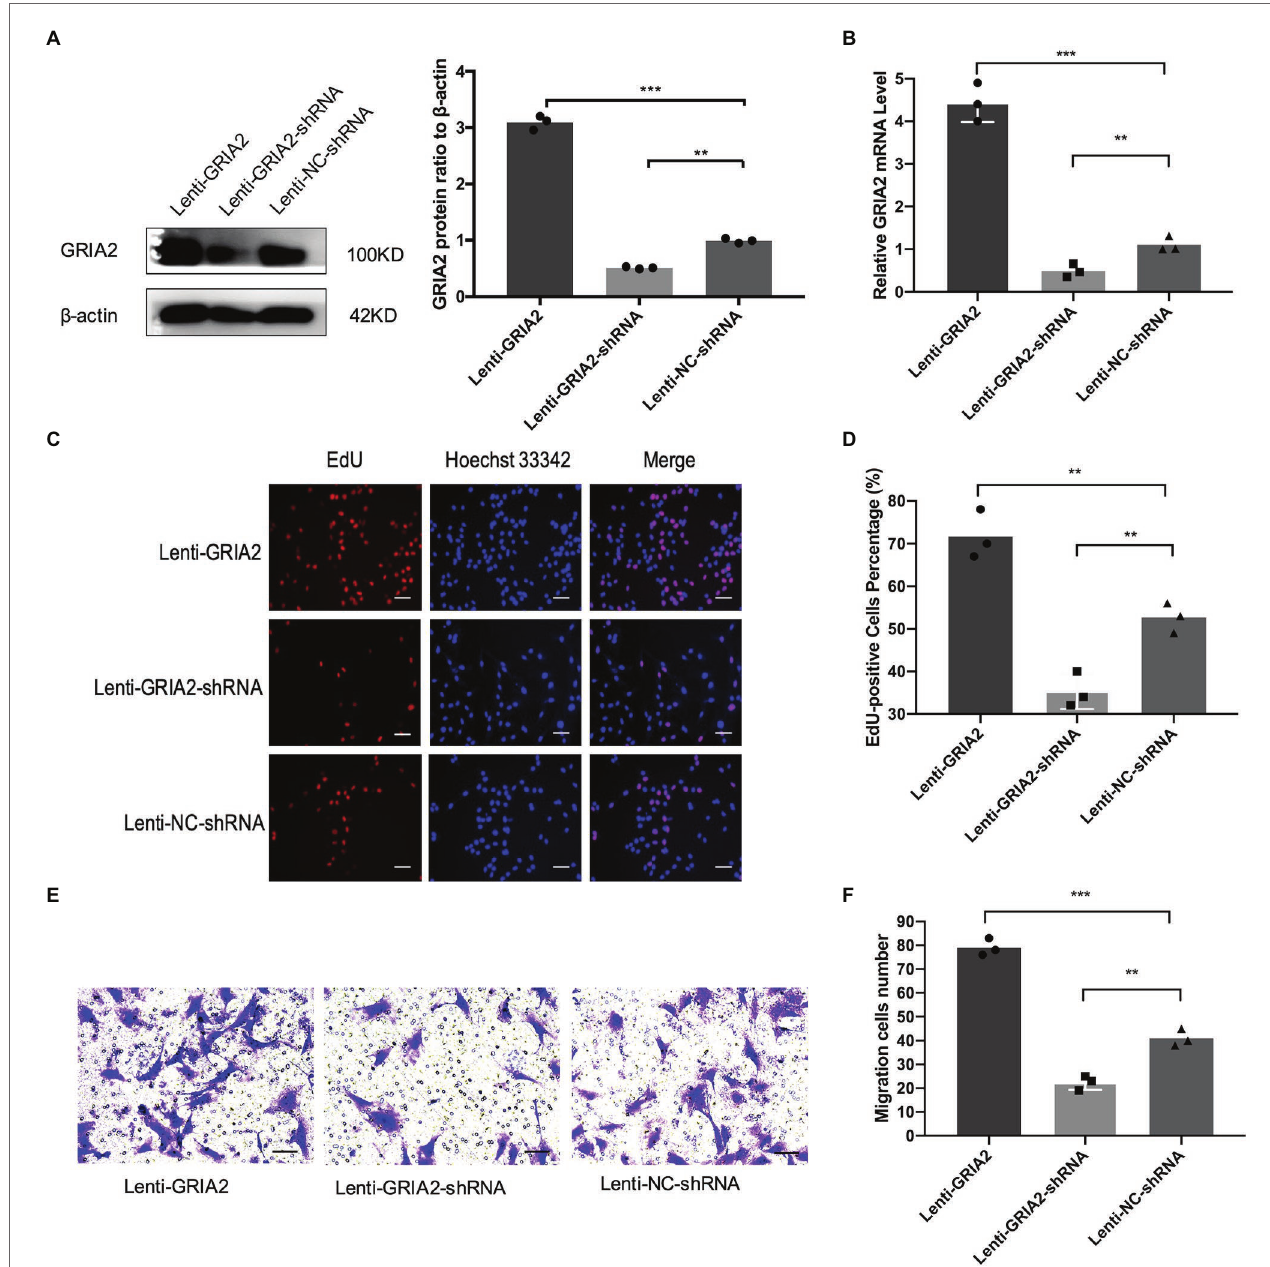
FIGURE 3 | The regulation of GRIA2 in VSMCs. (A) GRIA2 protein expression was detected by western blot after cDNA and shRNA regulation of GRIA2 . Blots are representative, and the bar graph shows the average data ( n = 3). (B) GRIA2 mRNA expression was detected by real-time PCR after transfection with lentivirus carrying GRIA2 shRNA, cDNA or empty vector ( n = 3). (C) EdU assay showed that increased EdU-positive VSMCs overexpressing GRIA2 were observed (scale bar, 50 μ m). Images are representative, and the bar graph shows the average data of independent experiments ( n = 3). (D) Rate of EdU-positive VSMCs ( n = 3). (E) Transwell migration assay of VSMCs after upregulating GRIA2 expression (scale bar, 100 μ m). Images are representative, and the bar graph shows the average data of three independent experiments ( n = 3). (F) Quantitative data on the migration of VSMCs ( n = 3). **Statistically significant difference ( p < 0.01) and ***statistically significant difference ( p <